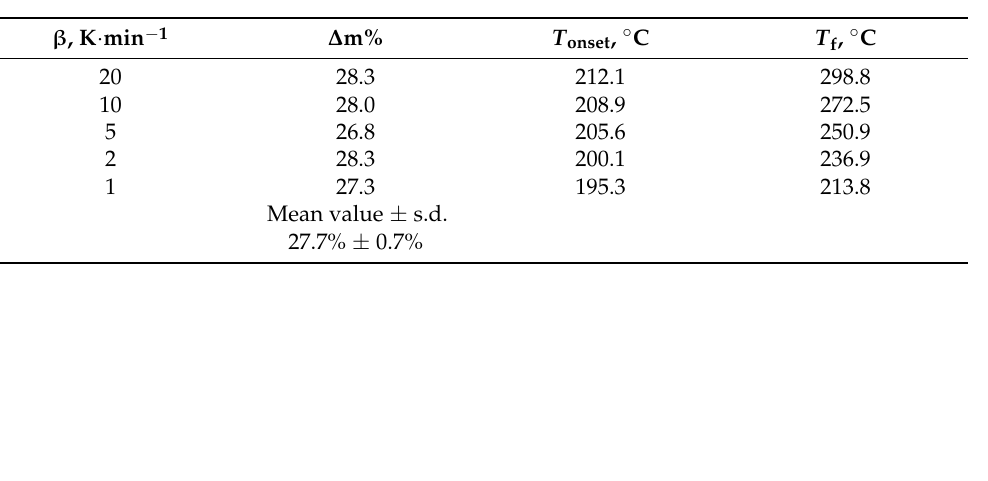
Table 1. Mass change, T onset , and T f of the DSC peak measured by SDT on a GPZ production batch under nitrogen flow at different heating